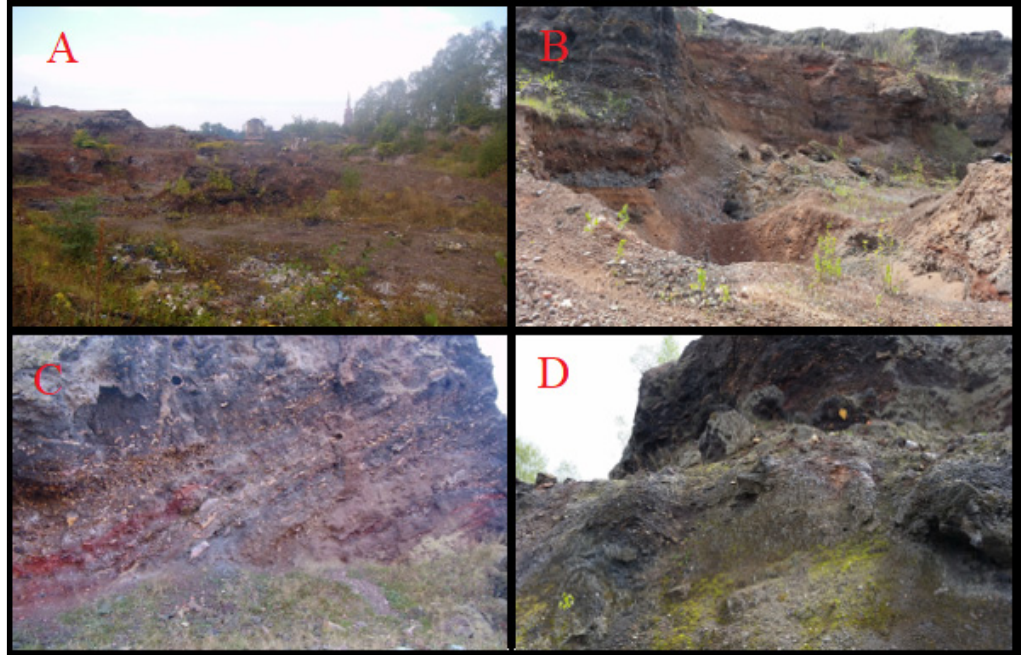
Figure 3. Photo documentation of the condition of the heap at the time of the survey: showing the exposure of the heap ( A ), its layered nature ( B ), fragments of ceramic metallurgical elements ( C ), mosses and lichens on the heap ( D ).